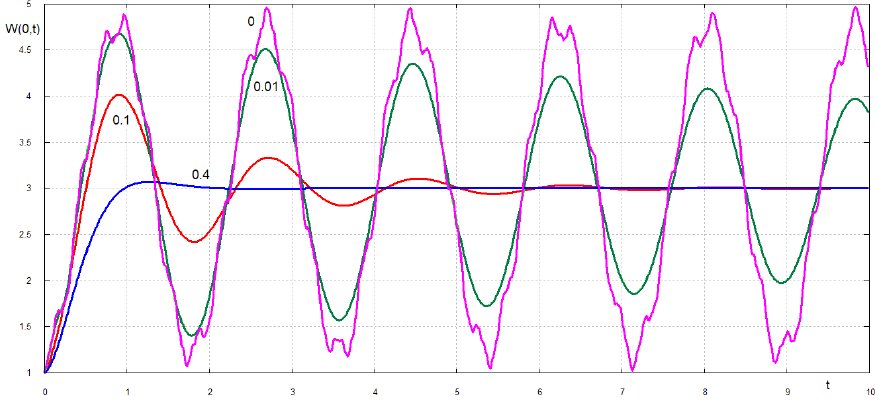
Figure 3. Displacements of the plate edge W ( 0, t ) after the plate breaking for small values of the dimensionless retardation time ˜ τ = 0.4,0.1,0.01,0.